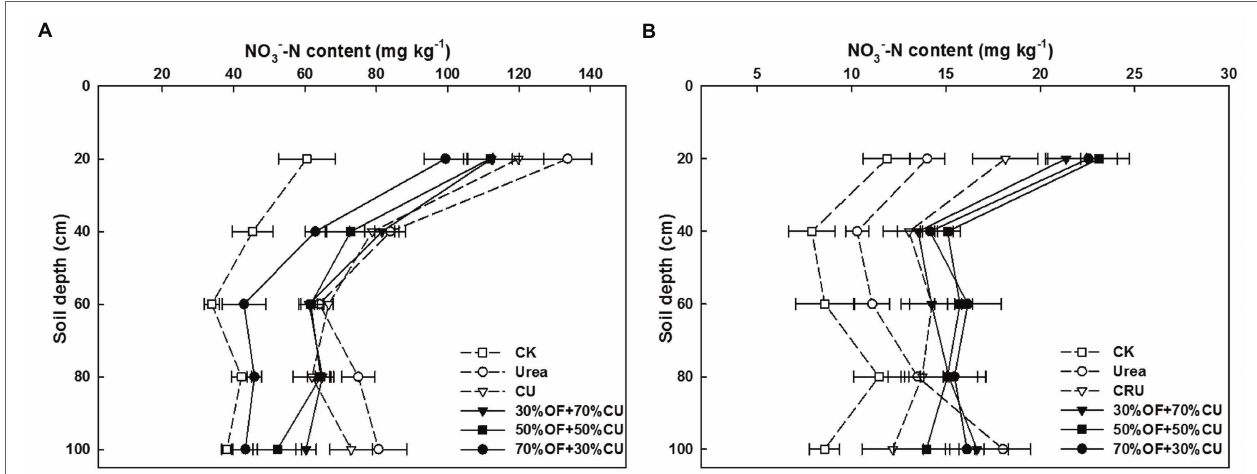
FIGURE 9 | The distributions of soil - NO 3 -N in the 0–100-cm soil profiles at the seedling stage (A) and mature stage (B) in 2019.